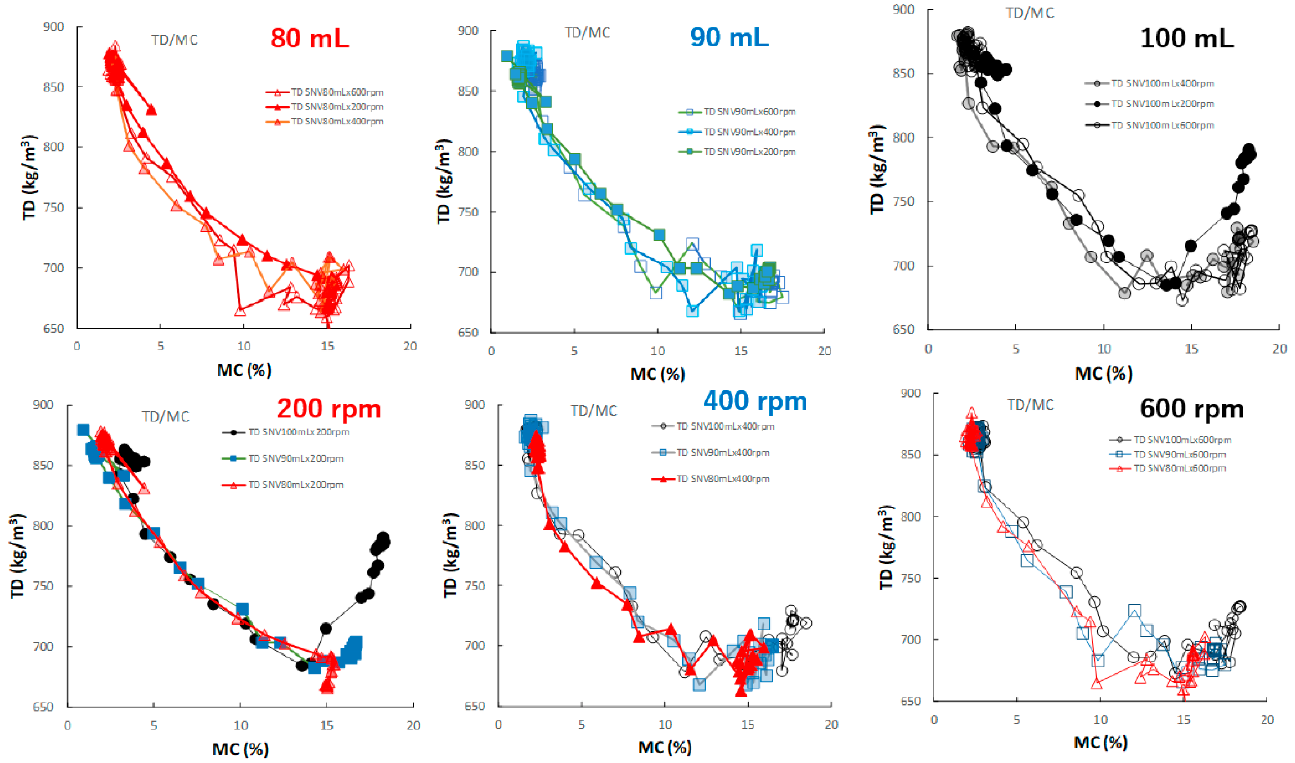
Figure 12. The effect of adding water and increasing stirring speed on the relationship between TD and MC of the HSWG granules.